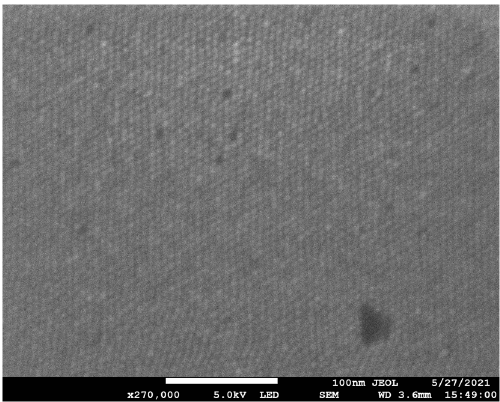
Figure 5. SEM image of a single layer of the gold nanoparticles that were synthesized and stamped onto a clean silicon surface. The white scale bar presented in the image represents 100 nm in length, providing gold nanoparticles of roughly 5 nm in diameter.